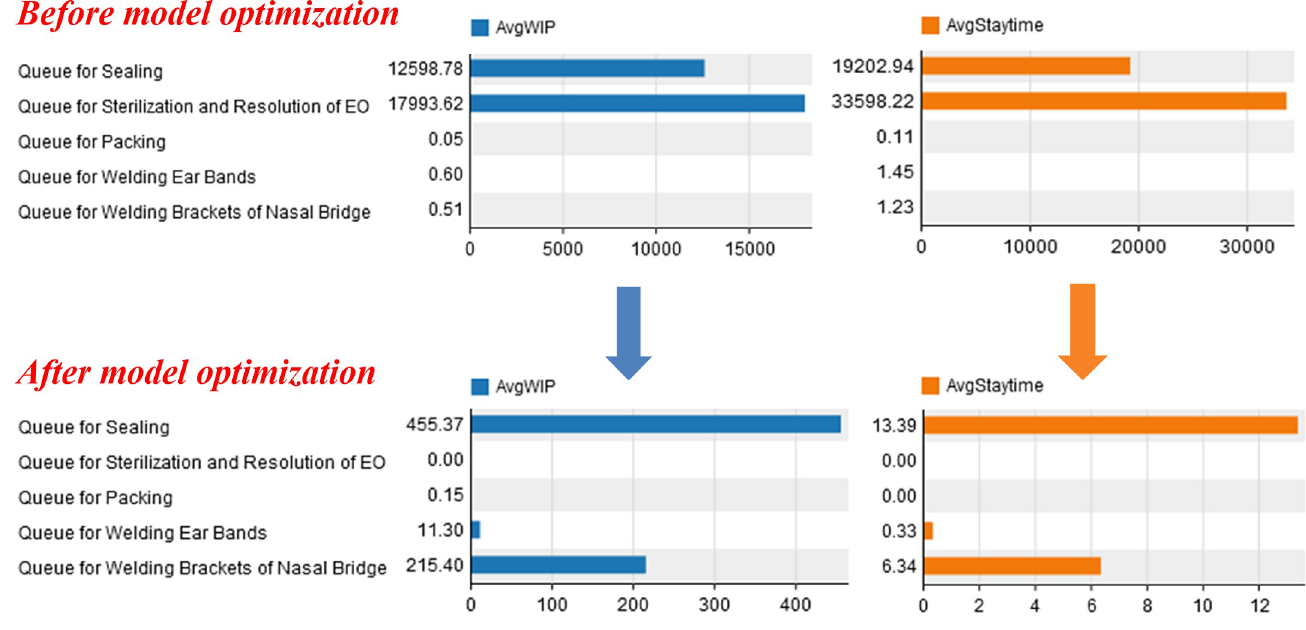
Fig 9. Comparison of AvgWIP and AvgStaytime before and after Model 4 optimization.